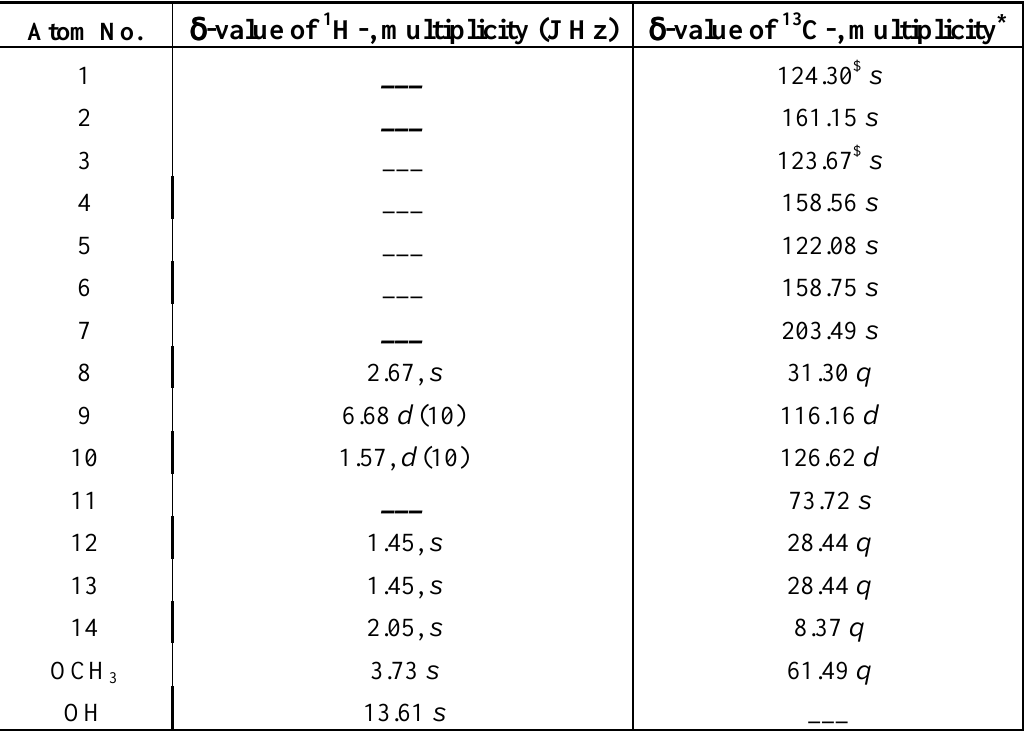
Table 1: 1 H-, 13 C -NMR data of compound